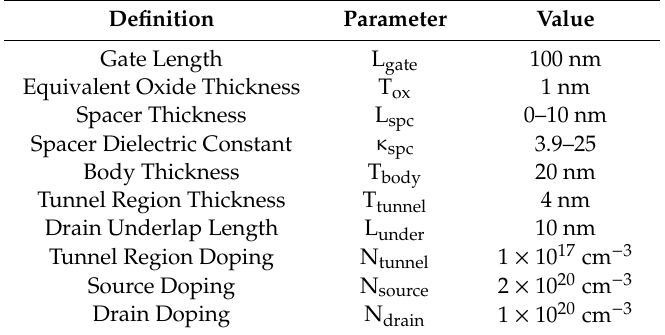
Table 1. Structure dimensions used in technology computer-aided design (TCAD)